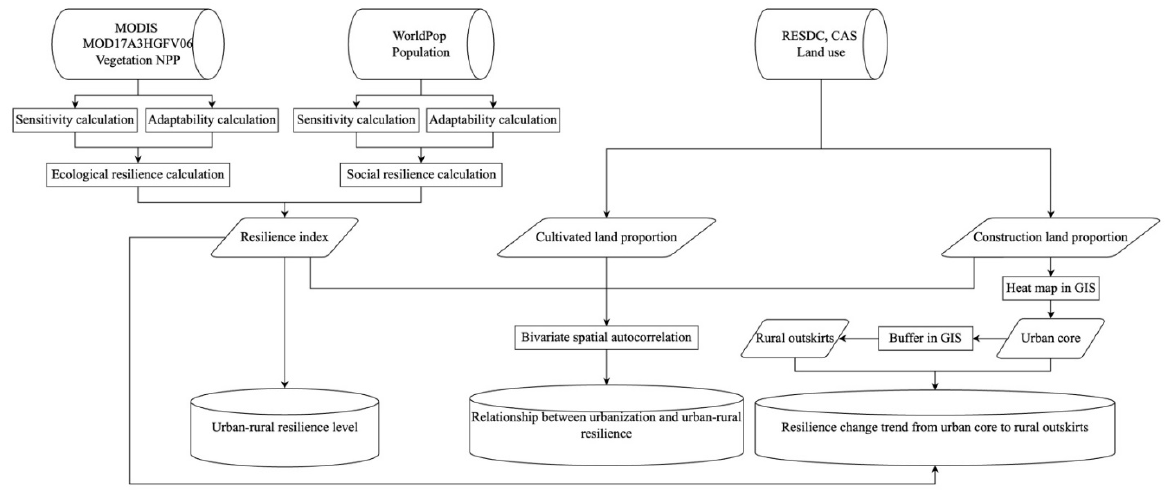
Figure 3. Methodology flowchart of this study.